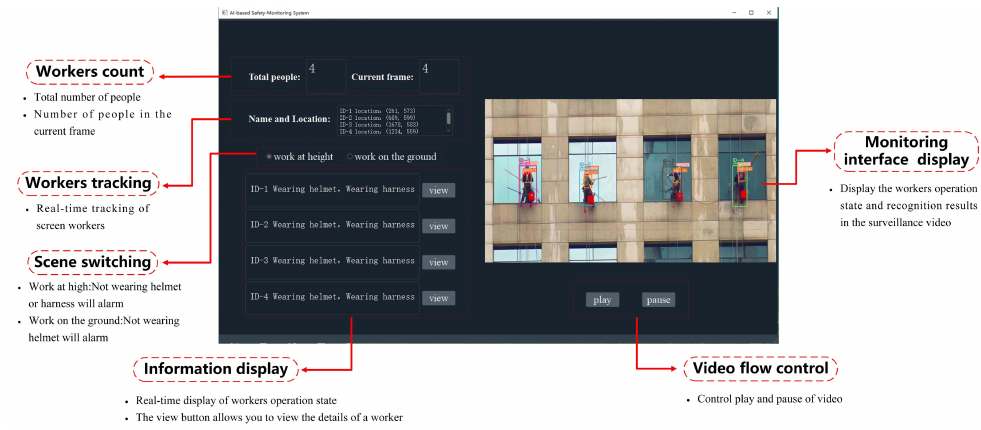
Figure 10. The visual UI interface